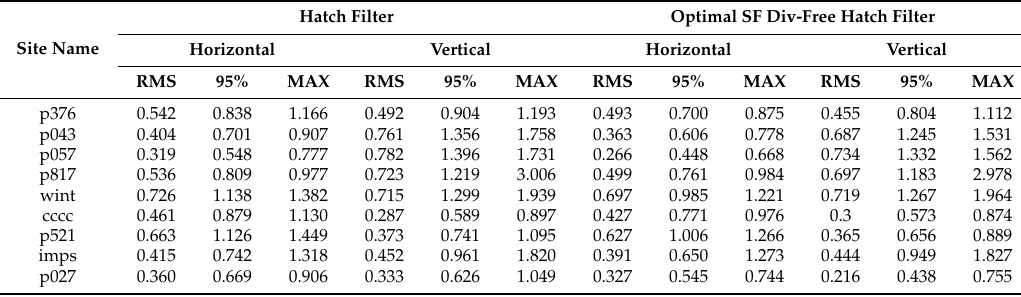
Table 5. Statistics of the position error for various sites